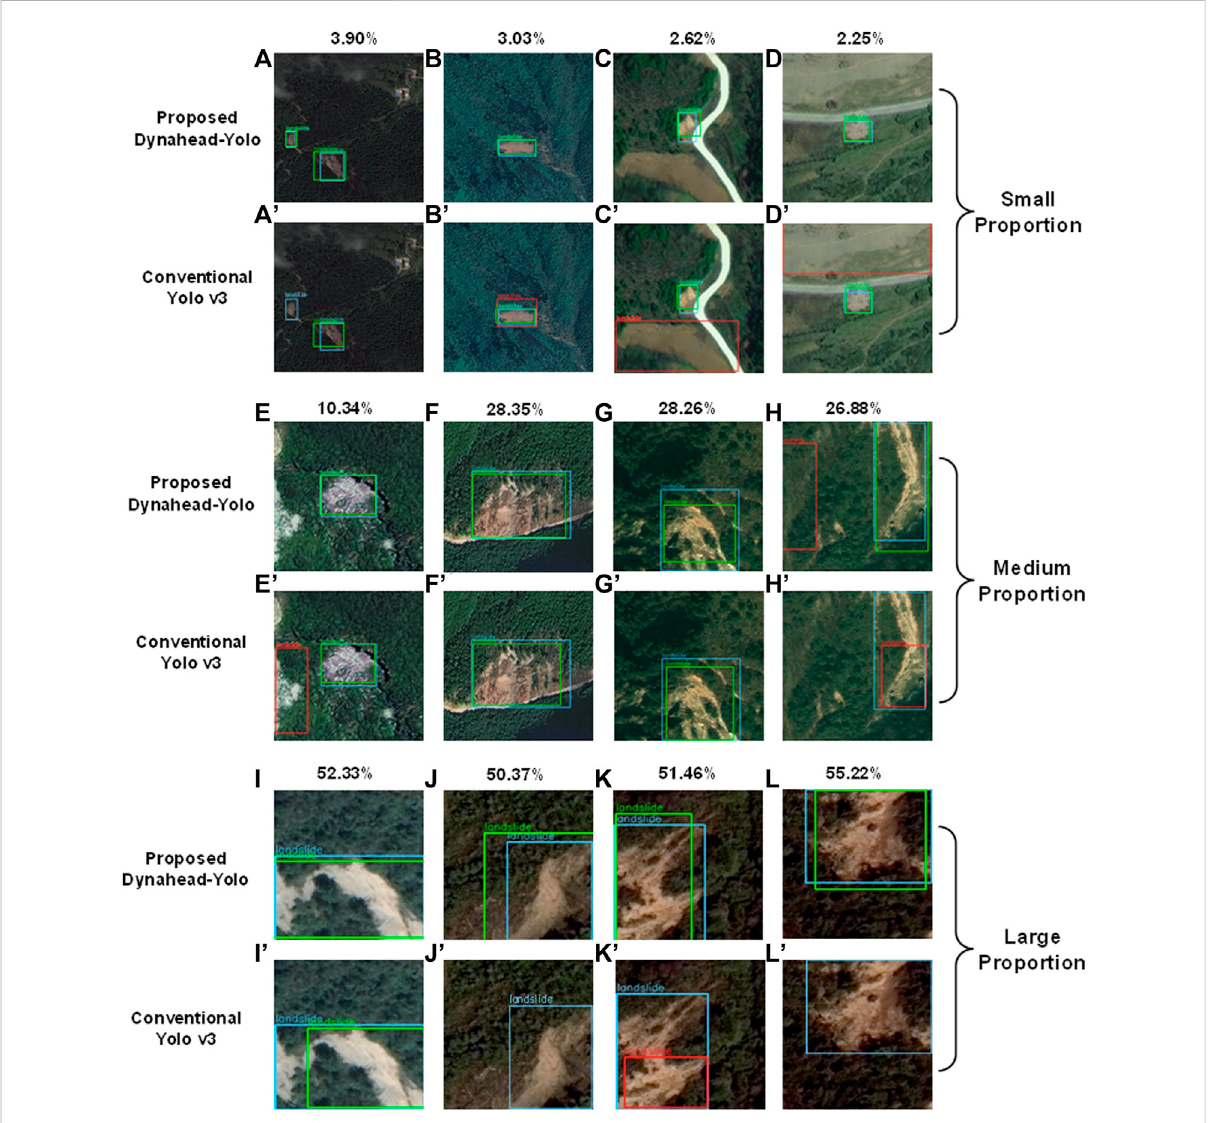
represent the detection results of Dynahead-Yolo and YOLO v3 for large-proportion landslides, separately.